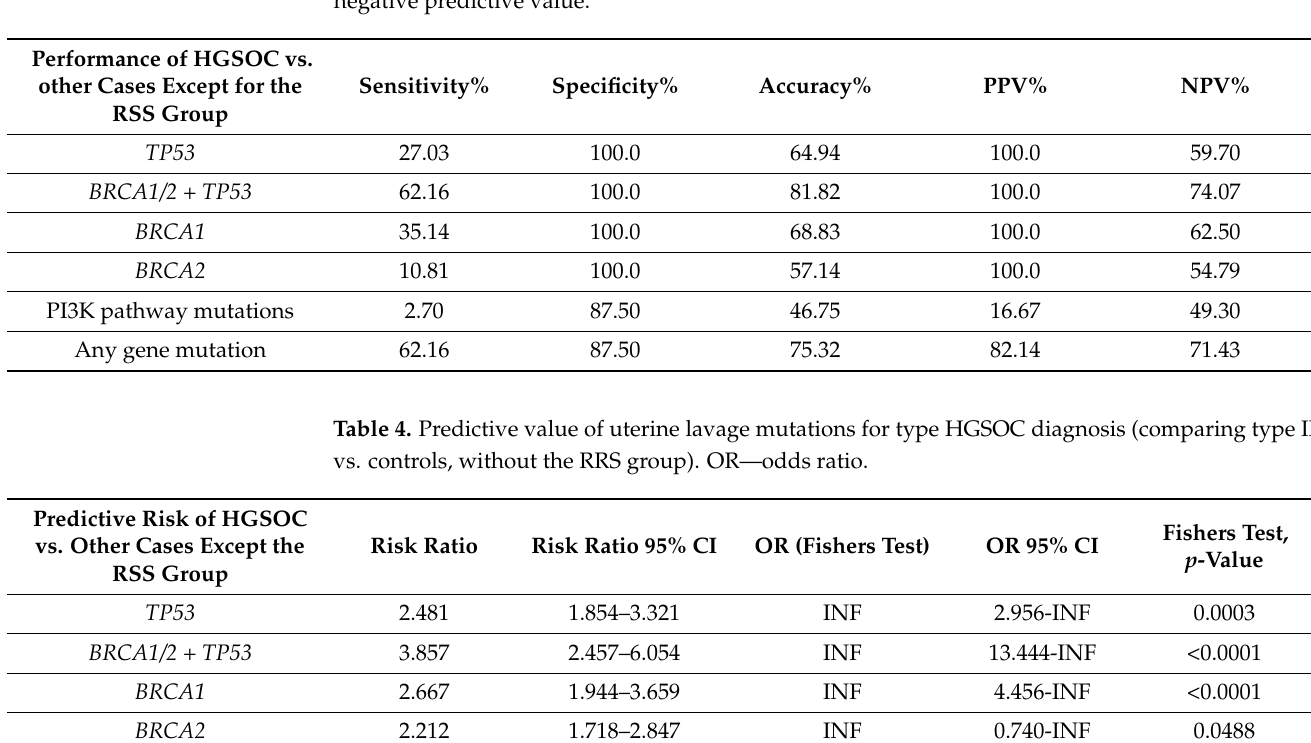
Table 3. Performance characteristics of uterine lavage mutations for type II ovarian cancer diagnosis comparing type II vs. controls, without the RRS group. PPV—positive predictive value, NPV— negative predictive value.